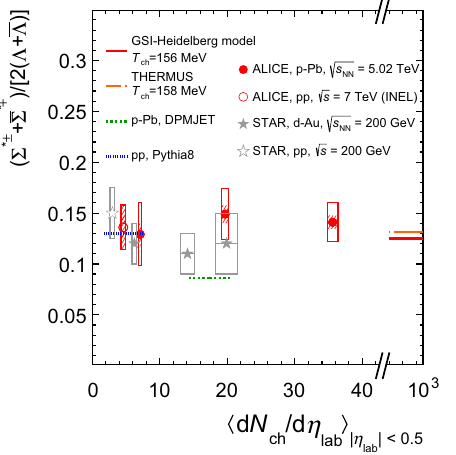
Fig. 8 ( Left ) ratio of (cid:3) ∗± to (cid:9) and ( Right ) ratio of (cid:4) ∗ 0 to (cid:4) − mea- sured in pp [17,32,37,39], d–Au [32,37] and p–Pb [10,24] collisions, as a function of (cid:3) d N ch /d η lab (cid:4) measured at midrapidity. Statistical uncer- tainties ( bars ) are shown as well as total systematic uncertainties ( hol-